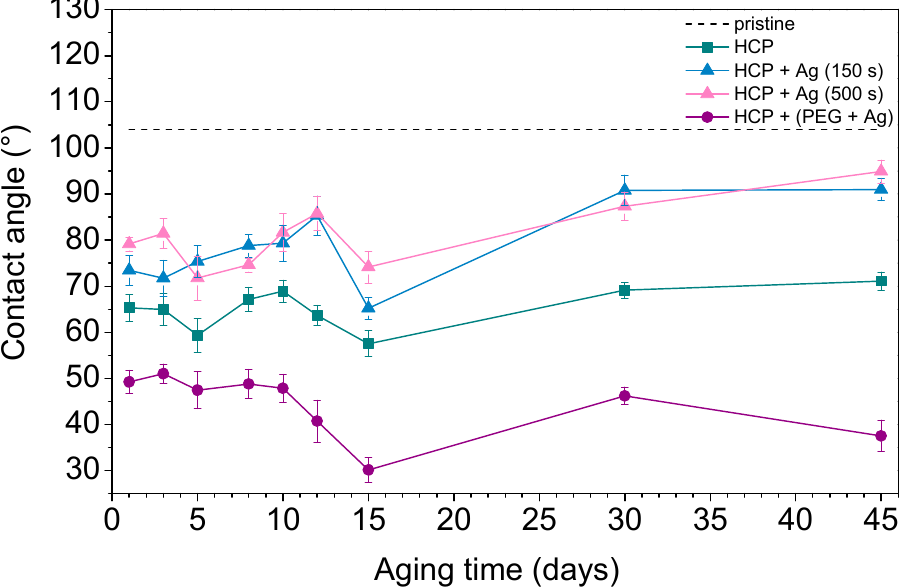
Figure 7. The water contact angles over 45 days for pristine fluorinated ethylene propylene (FEP) and the prepared honeycomb-like (HCP) structure and its modified samples, with Ag layers sputtered for 150 s and 500 s and deposition of AgNPs into polyethylene glycol (PEG).